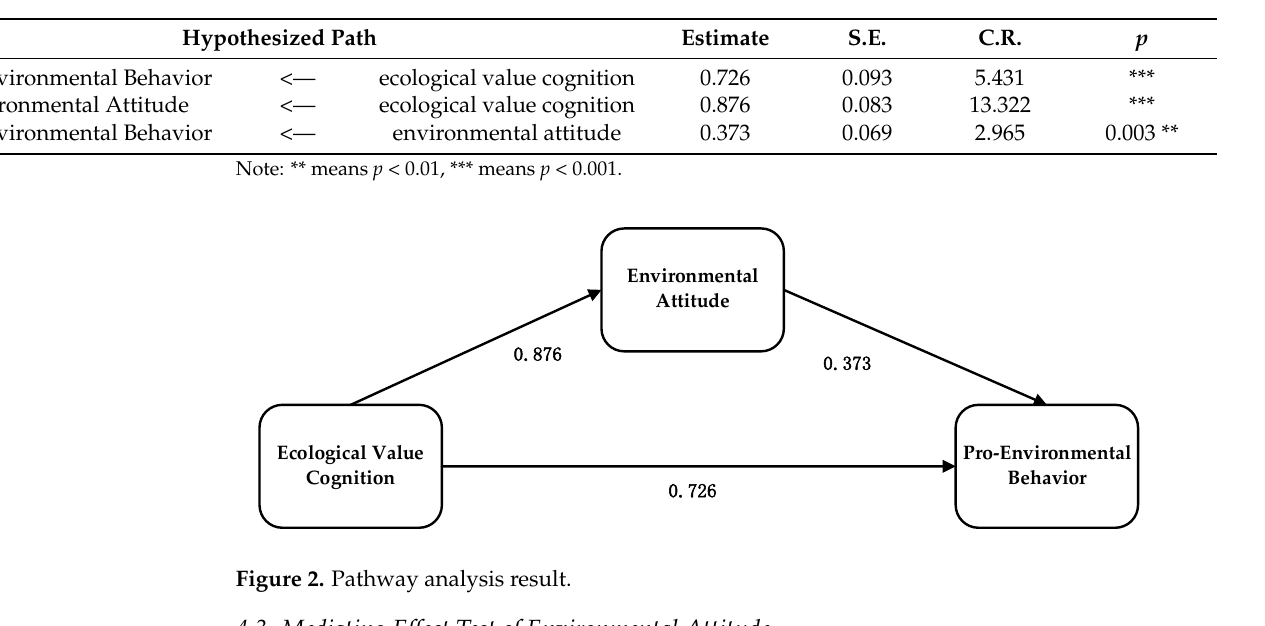
Table 10. Pathway analysis result.